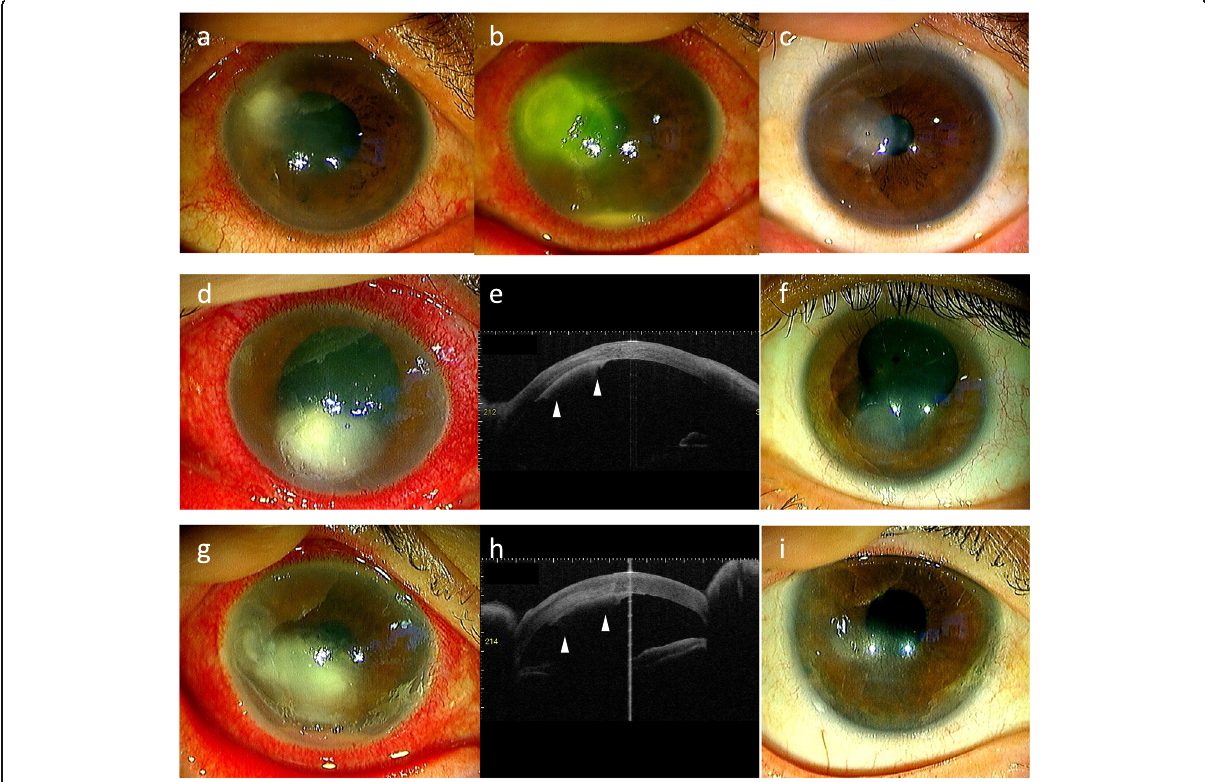
Fig. 1 Slit-lamp and anterior segment optical coherence tomography (ASOCT) photographs obtained in each of the cases. Case #1: The feathery infiltration observed at the first visit ( a ) expanded to the central cornea and showed a ring-shaped lesion and hypopyon ( b ). At 2 months, there was keratitis scarring observed ( c ). Case #2: Full-thickness feathery infiltration ( d ) and ASOCT scanning of the retrocorneal plaque ( e , arrowheads) performed at the first visit. At 2 months, keratitis scarring was observed ( f ). Case #3: Deep stromal feathery infiltration ( g ) and ASOCT scanning of the retrocorneal plaque ( h , arrowheads) performed at the first visit. At 2 months, keratitis scarring was observed ( i